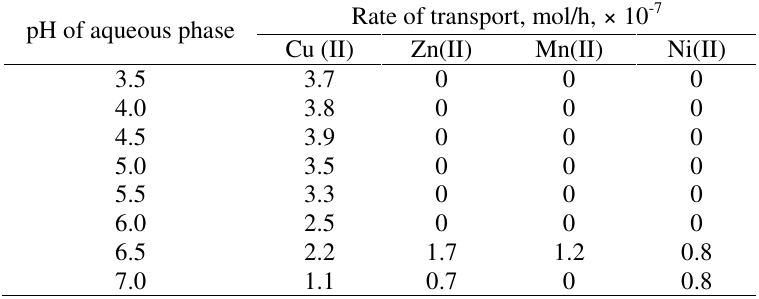
Conditions: Initial concentration of [Cu(II), Mn(II), Zn(II) and Ni(II)] 10 mM, Time: 24